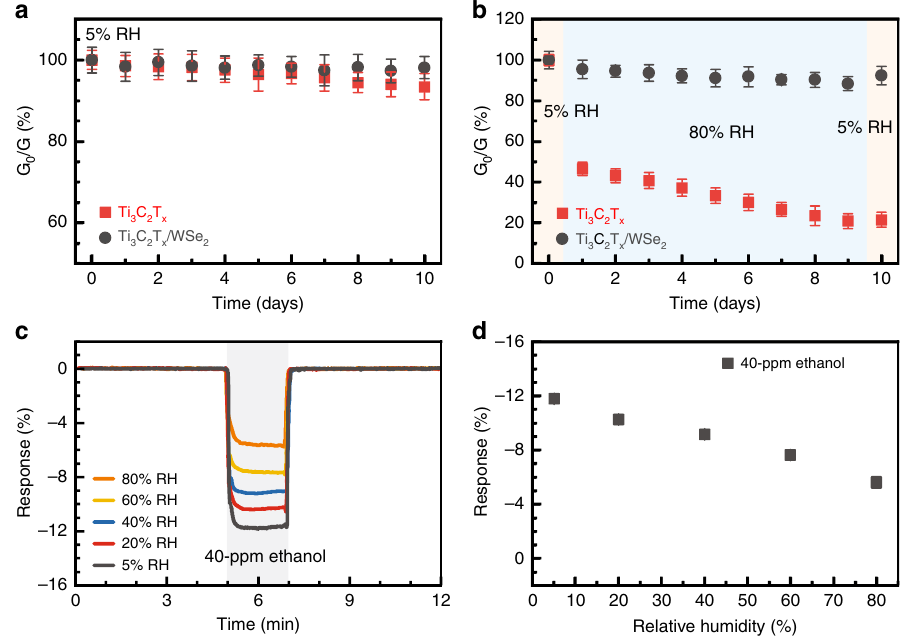
Fig. 5 Environmental stability of Ti 3 C 2 T x and hybrid Ti 3 C 2 T x /WSe 2 fi lms. Changes in electrical conductance of pristine Ti 3 C 2 T x and hybrid Ti 3 C 2 T x /WSe 2 sensors under a 5% RH and b alternative RHs of 5 and 80% over 10 days. c Evolution of responses of Ti 3 C 2 T x /WSe 2 sensors to 40 ppm of ethanol under various RHs and d the sensing responses as a function of RHs from 5 to 80%.